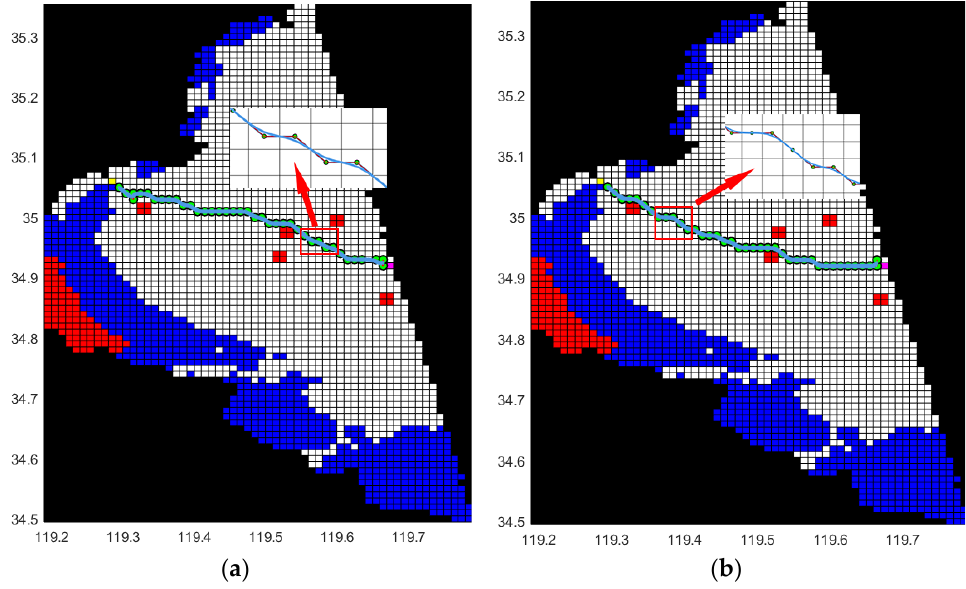
Table 1. Related parameter settings.